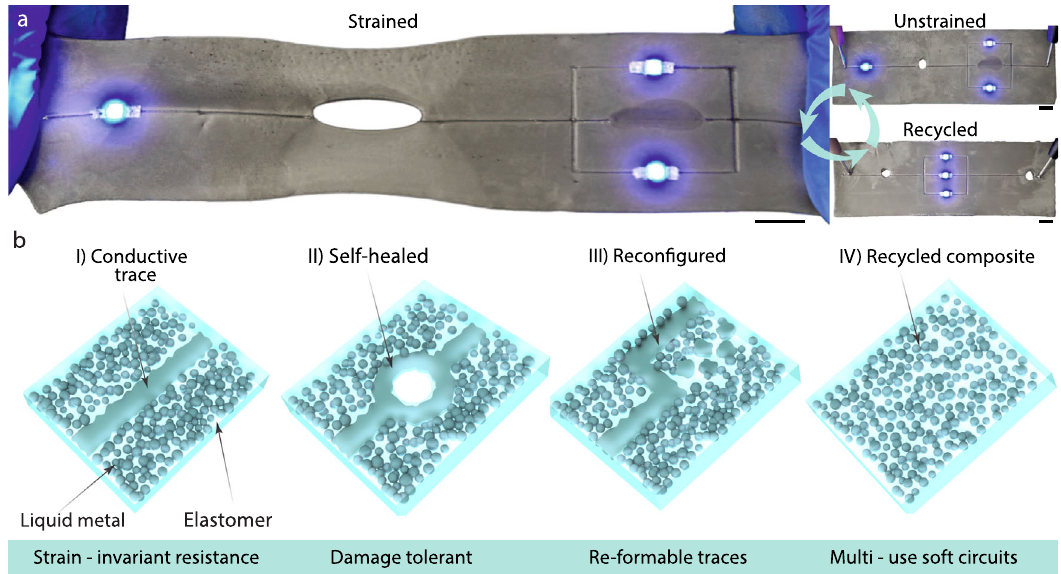
Fig. 1 Liquid metal composites for regenerative electronics. a A liquid metal composite demonstrated as a singular system for soft circuits with robust, self-healable conductive traces with strain-invariant resistance at different resistance levels. Unstrained and recycled samples show the LEDs functioning before stretching and after recycling (scale bars — 10 mm). Material composition ϕ = 60%, δ = 20%. b Schematics show the transformation of liquid metal microstructure to enable the above capabilities — strain-invariant resistance of a conductive trace created through embossing to form a network of liquid metal particles. Damage tolerant traces through an autonomous recon fi guration of liquid metal particle connections for self-healing electronics. Reformable traces are enabled by erasing a previously formed liquid metal network and creation of a new network through a solvent erase approach. Multiuse soft circuits through dissolving the composite, which erases all liquid metal networks and electrical traces, and recycling for use in new applications.